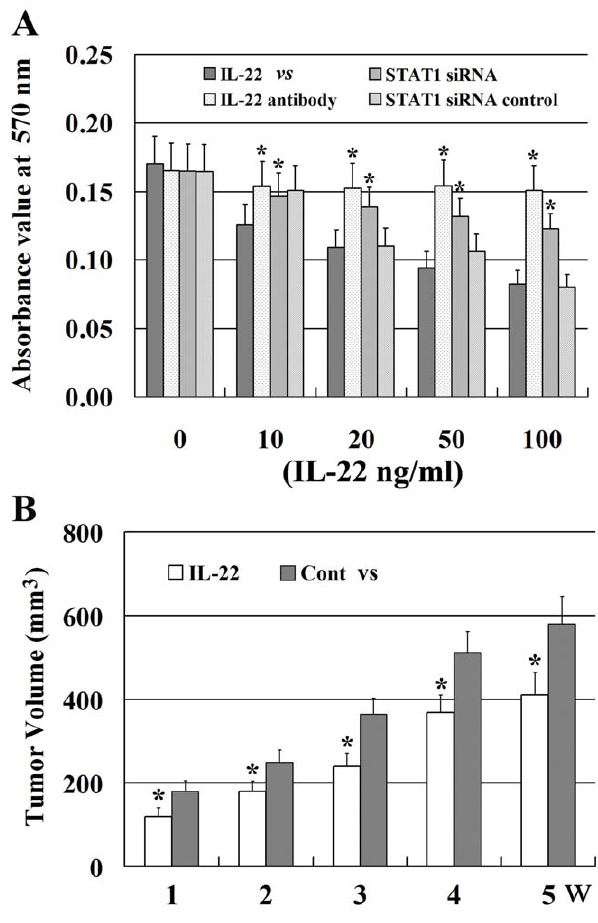
Figure 1. Suppression of A498 cell growth in vitro and in vivo by rhIL-22. A. IL-22 suppressed the growth of A498 cells in vitro in a dose-dependent manner. The growth inhibition of A498 cells exposed to IL-22 was revised by IL-22 antibody neutralization or by STAT1 specific siRNA transfection compared with the control (*P , 0.05). Compared with A498 cells transfected with STAT1 siRNA, the growth inhibition of A498 cells treated with IL-22 antibody was not statistically different after IL-22 exposure (P . 0.05). N=4 and mean 6 SD for all groups. B. Suppressive effect of rhIL-22 on A498-cell-bearing xenografts in mice. When tumors reached 100 mm 3 , rhIL-22 was injected into the tail vein 0.5 m g /day for 7 days; control mice were injected with the same volume of PBS. Tumor size was measured with a caliper each week for five weeks; tumor volume was determined by measuring the maximal (a) and minimal (b) diameters using a caliber and calculating using the formula a 6 b 2 . After five weeks, mice were sacrificed under deep anesthesia and the final volume of the tumors was measured. *P , 0.05 compared with control. N=24 and mean 6 SD for all groups.